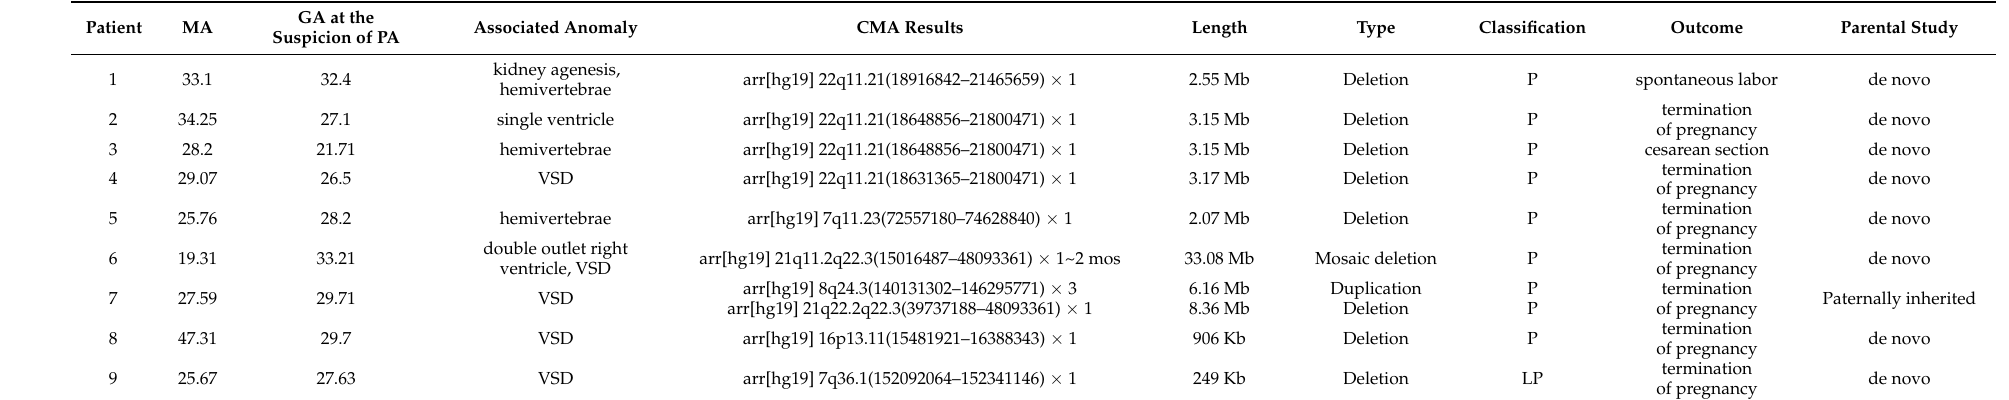
Table 2. Pathogenic and likely pathogenic copy number variations identified in the cohort of fetuses with pulmonary atresia.